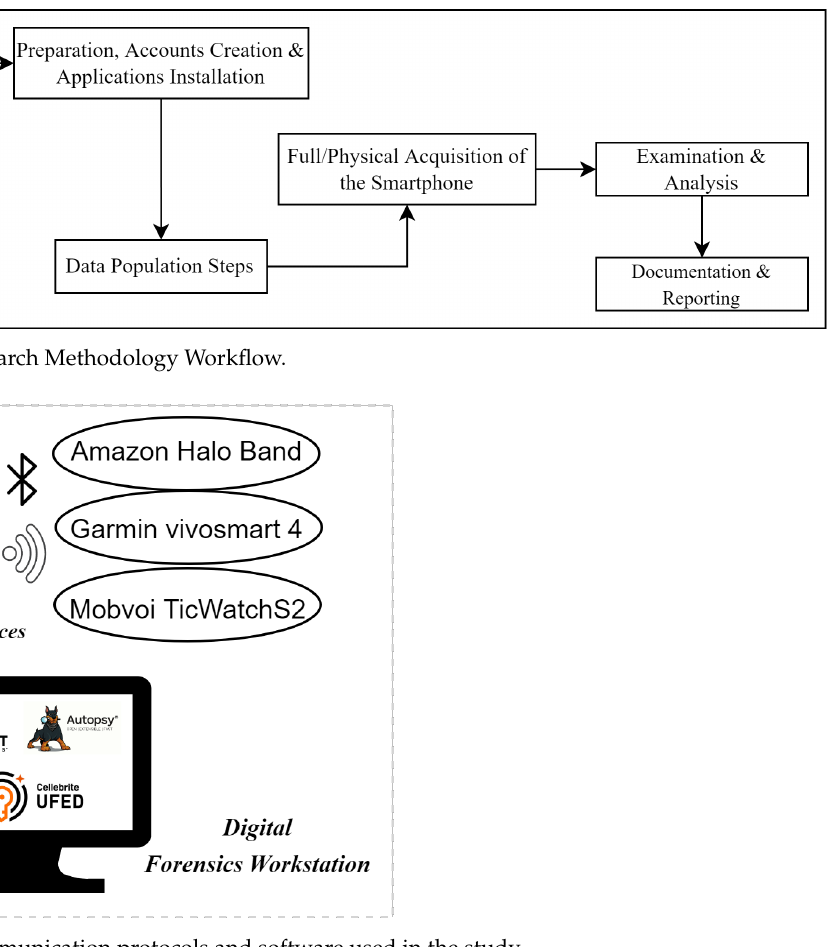
Figure 3. Communication protocols and software used in the